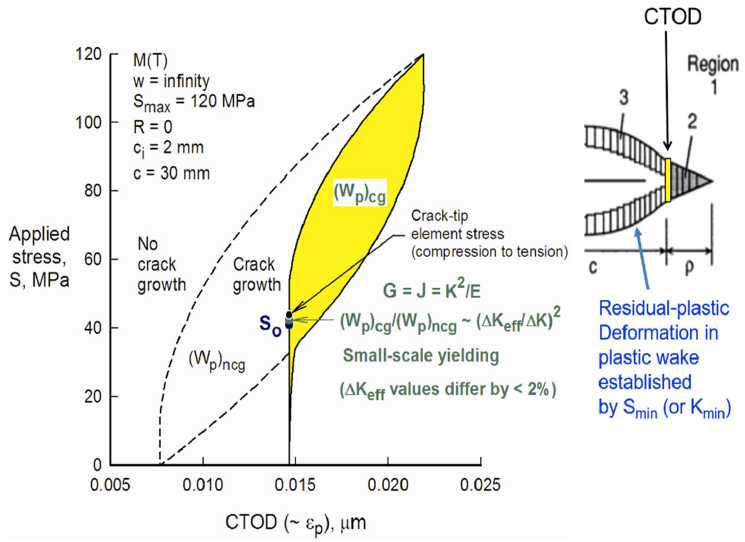
Figure 2. FASTRAN simulation of the crack tip deformation.